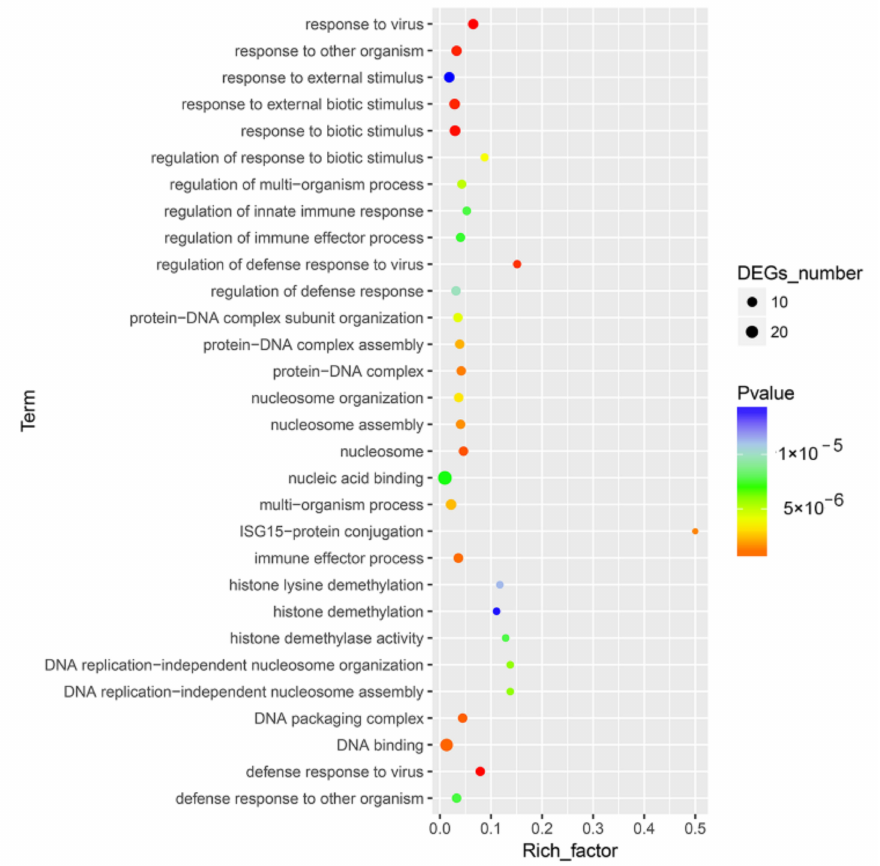
Figure 3. GO enrichment analysis for the DEGs between CpHV-1-infected and mock-infected MDBK cells. The abscissa represents the enrichment factor, and the ordinate represents the GO function classification. Circles indicate numbers of enriched genes, and colors depict the p -value. The enrichment factor was calculated using the number of enriched DEGs divided by the total number of background genes in the corresponding pathway. The size of each circle represents the number of significant DEGs enriched in the corresponding pathway. The chromatogram from blue to red represents the uncorrected p -value. A detailed representation of the data is provided in Table S2. To further define DEG function, KEGG pathway/enrichment analysis was